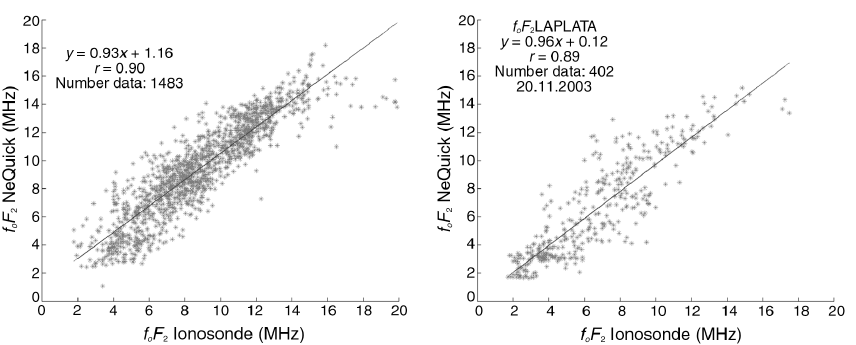
Fig. 4. Linear regression fitting for reconstructed and experimental f o F 2 during quiet ( left ) and storm ( right ) con- ditions.